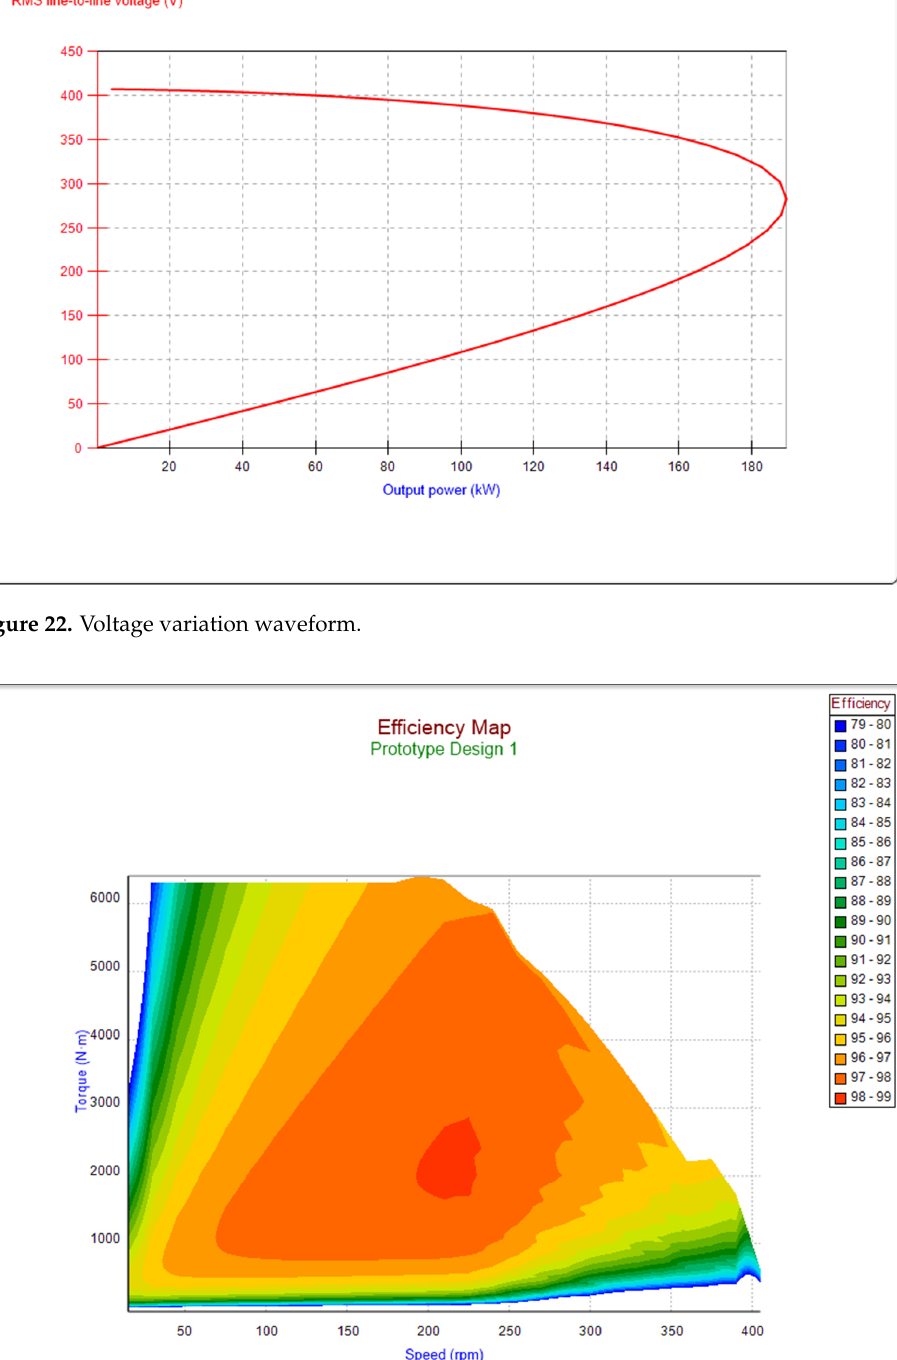
Figure 23. Generator efficiency